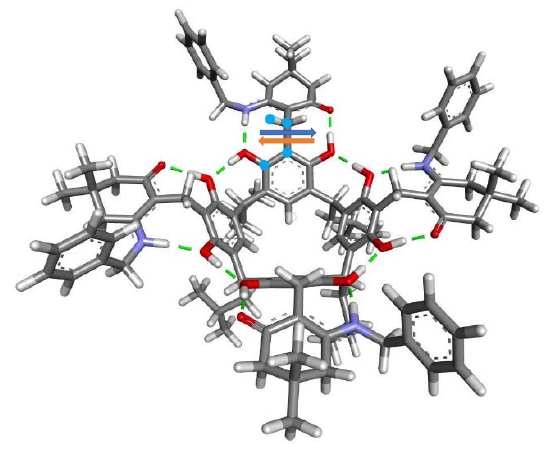
Figure 6 . The structure of all ‐ out conformer of derivative 4 with the direction of dihedral angle (atoms marked in blue) marked with an arrow: blue arrow—increasing the value of the dihedral angle; orange arrow—decreasing the value of the dihedral angle.